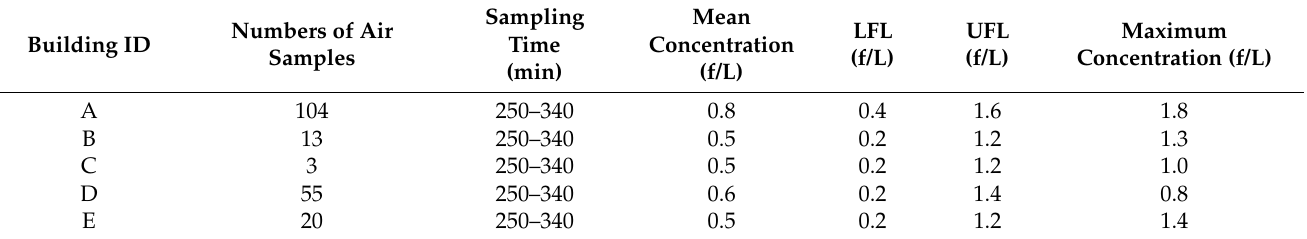
Table 2. Mean airborne asbestos fiber concentration measured in buildings with friable ACMs. LFL, UFL and maximum concentration measured are also shown.